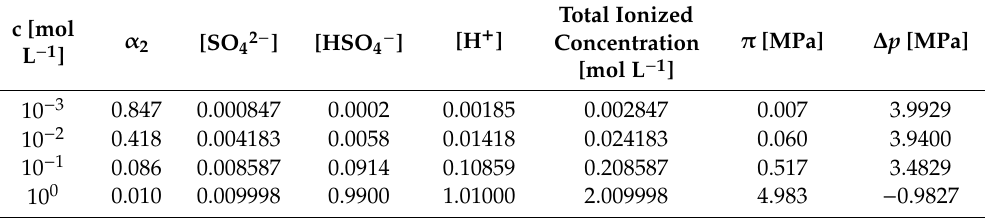
Table 1. Ion species abundance and osmotic pressure.